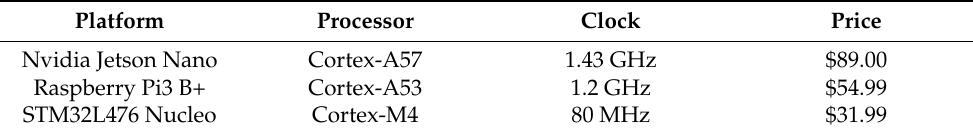
Table 15. The specification of three representative embedded development